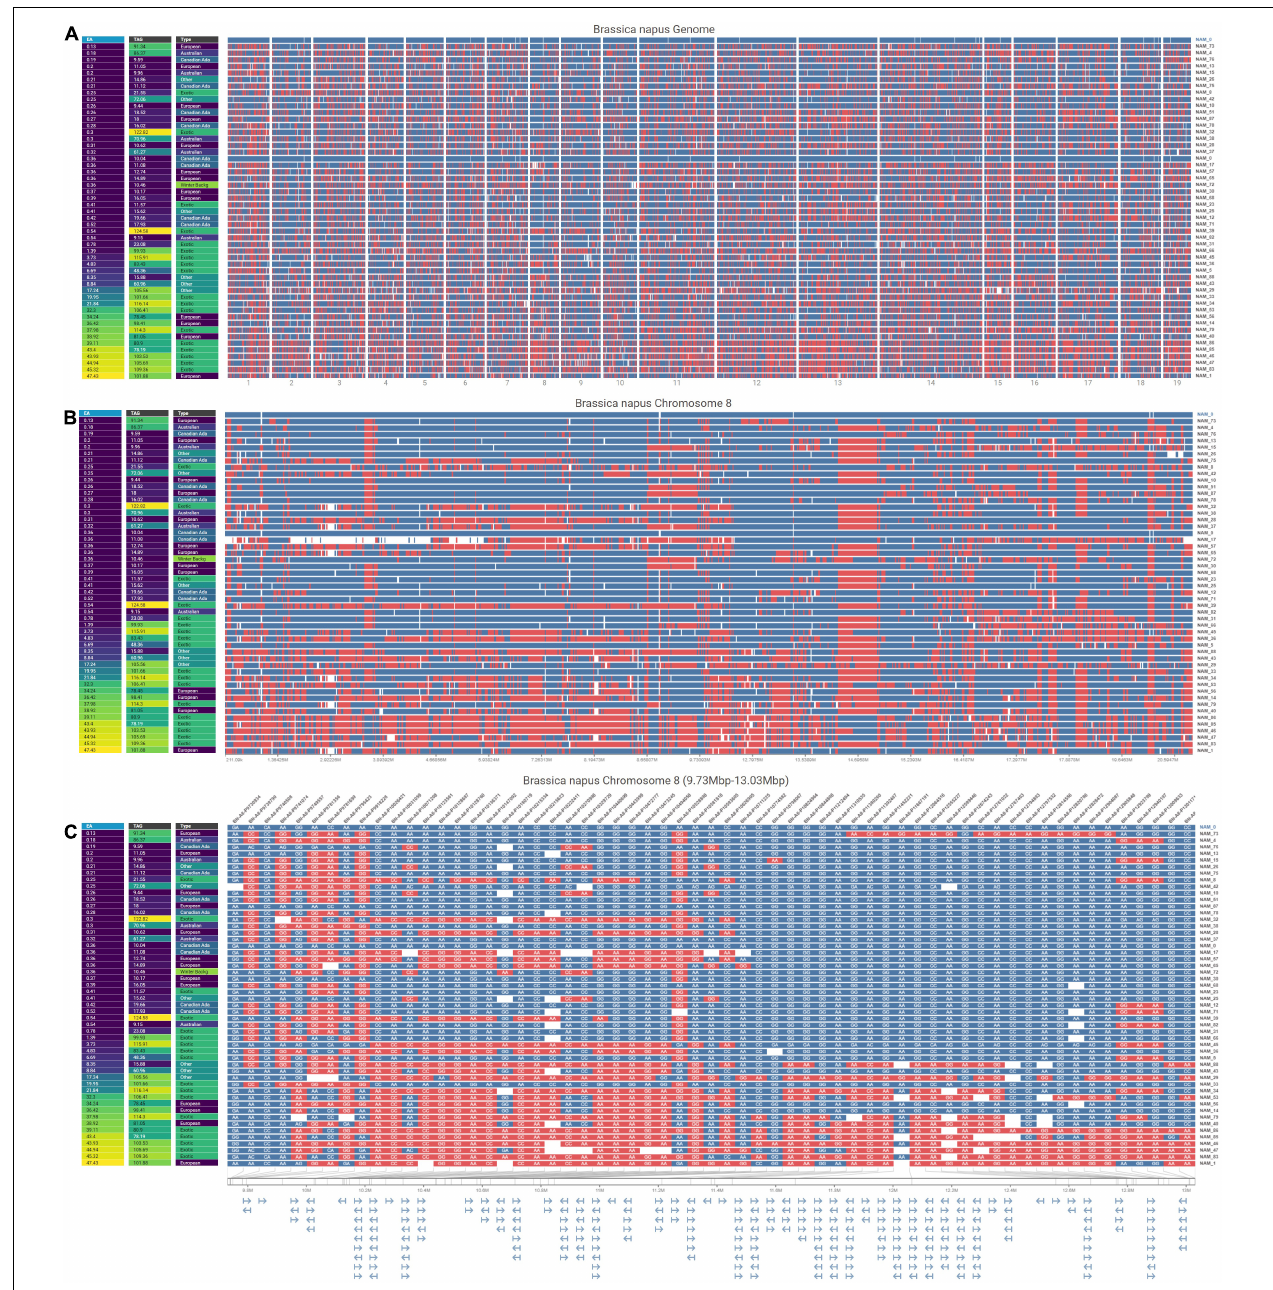
FIGURE 6 | Visualizations at three resolutions comparing SNPs in 50 B. napus genotypes against a reference genotype (NAM 0) with the genotypes ordered by their increasing erucic acid content. The visualizations are all organized with rows representing different lines, and columns of pixels representing each SNP. The color at each SNP indicates whether that SNP is the same (blue) as or different (red) from the allele in the reference genotype shown at the top of the view and missing data is encoded in white. Additionally, at each resolution, a map of phenotypic trait values (erucic acid content, total aliphatic glucosinolate levels, and genotype origin) are shown on the left. (A) Genome-level overview of the entire B. napus genome horizontally separated by chromosome. (B) Chromosome-level view of chromosome 8 in B. napus . (C) SNP-level view of chromosome 8 (9.73 mb to 13.03 mb) that displays SNP names at the top of the column, nucleotides for each SNP, and a gene map below the main